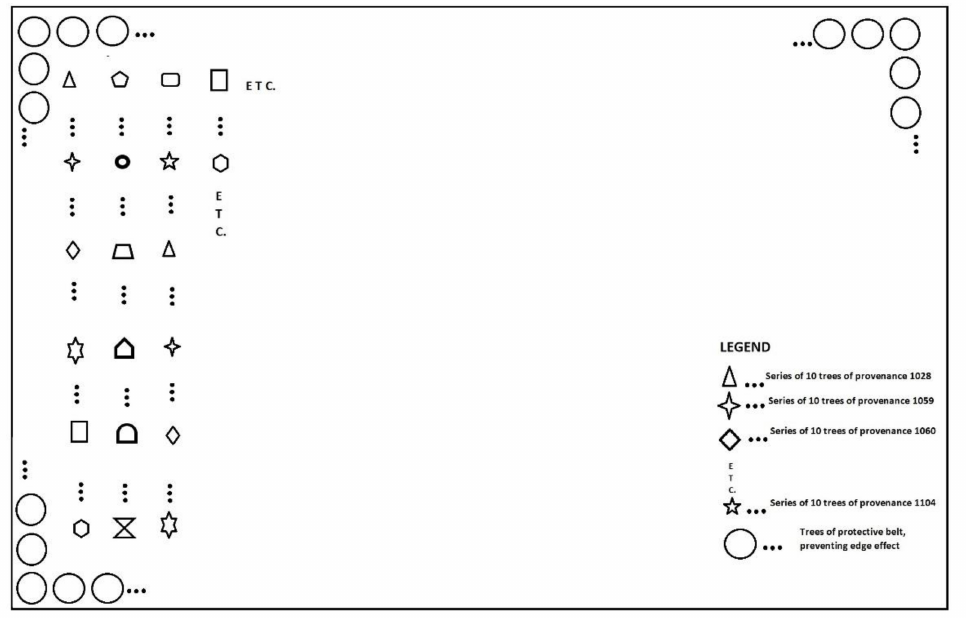
Figure 1. Experimental plot design with legend. The distance between individual trees and rows is 2.5